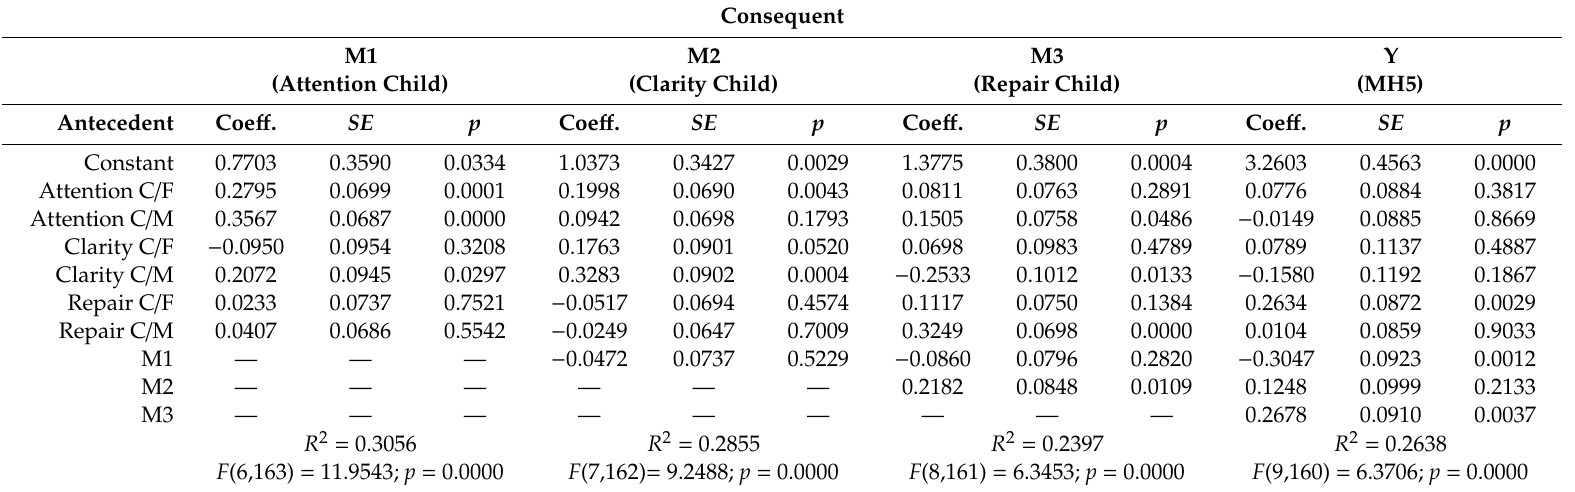
Table 4. Regression coe ffi cients, standard errors, and model summary information for the serial multiple mediator model with EI perceived by children about parents as explanatory variables (model related to